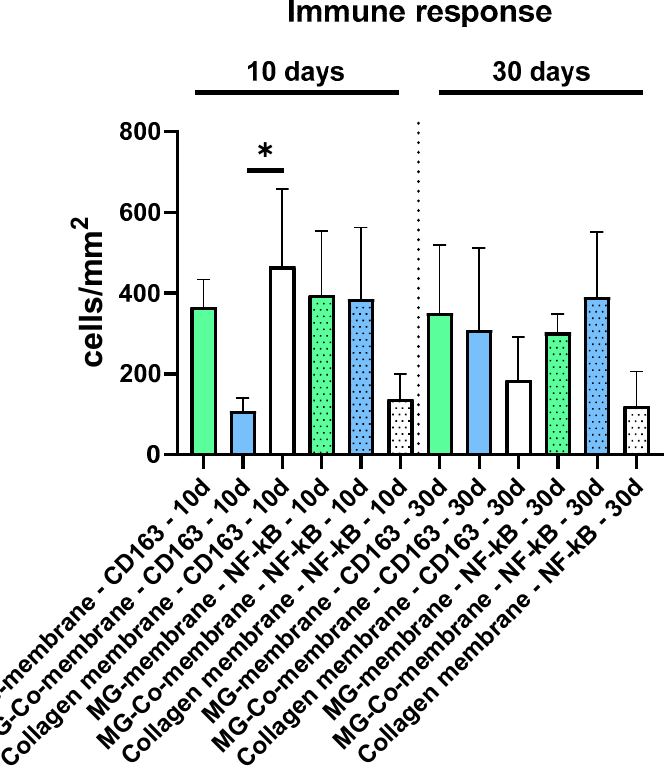
Figure 7. Histomorphometric results of the immune response, i.e., the detection of anti- (CD163 antigen) and pro-inflammatory macrophages (NF- κ B antigen) at day 10 and day 30 post implantationem (separated by the dotted line) (* p < 0.05).